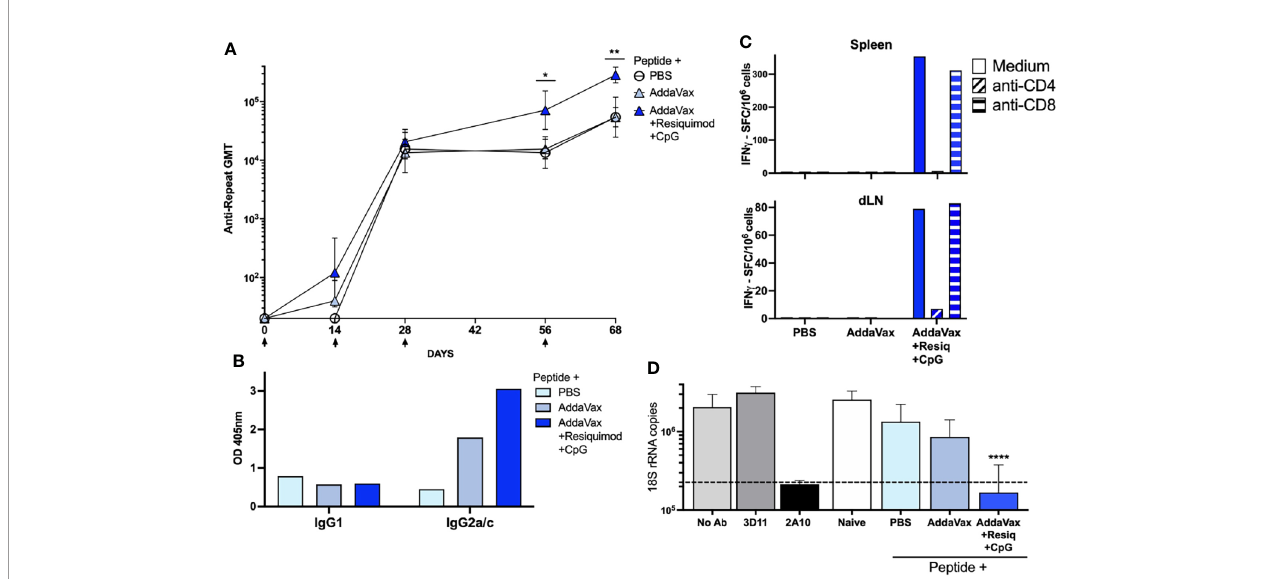
FIGURE 1 | SS with P. falciparum CS peptide in AddaVax containing TLR agonists elicits Th1- type neutralizing antibody and cellular responses. (A) Kinetics of anti- CS repeat IgG response following SS immunization. Sera was collected 14d post each SS immunization (arrows) with CS peptide in PBS, AddaVax or AddaVax + Resiquimod + CpG. ELISA geometric mean IgG titers (GMT) are shown for sera from individual mice ( n = 5/group). Mann-Whitney test showed a signi fi cant difference in antibody titer post 3 rd dose (p = 0.0317) and post 4th dose (p = 0.0079) with SS immunization with CS peptide in AddaVax + Resiquimod + CpG compared to CS peptide in AddaVax only. Error bars show standard deviation. (B) Anti-CS repeat IgG isotypes in serum of SS immunized mice. ELISA was carried out using MAB speci fi c for Th2-type IgG1 or Th1-type IgG2a/c. Data are shown as OD of pooled serum (1:320 dilution) obtained post fourth SS immunization from each group of mice ( n = 5 mice/group). (C) T cell cytokine responses in spleen and dLN of SS immunized mice. IFN g ELISPOT was carried out using pooled spleen or dLN cells (5 mice/group) obtained post fourth SS immunization with CS peptide in PBS, Addavax only or Addavax + Resiquimod + CpG. Data are shown as SFC/10 6 after subtraction of medium only control. (D) Sporozoite neutralizing antibody in serum of SS hyperimmunized mice. TSNA was measured using serum (1:5 dilution) of individual mice (n = 5 mice/group) obtained post fourth SS immunization. Mean number of 18S rRNA copies in cultures were quantitated by qRT-PCR. Controls (gray bars) included MAB 2A10 as a inhibitory antibody positive control, or MAB 3D11 as a negative antibody control, and no antibody (No Ab). Dotted line indicates 90% reduction in parasite rRNA copy numbers. Serum from mice immunized SS with CS peptide in AddaVax + Resiquimod + CpG gave >90% inhibition (dotted line), with a signi fi cant reduction in parasite copy numbers when compared to naïve serum (One-way ANOVA of log transformed data with Dunnett ’ s multiple comparisons test and adjusted p values, ****p < 0.0001). No signi fi cant difference in 18S rRNA copy numbers was found in cultures containing serum of mice immunized SS with PBS or AddaVax compared to naïve. (*p = 0.0317) and (**p =